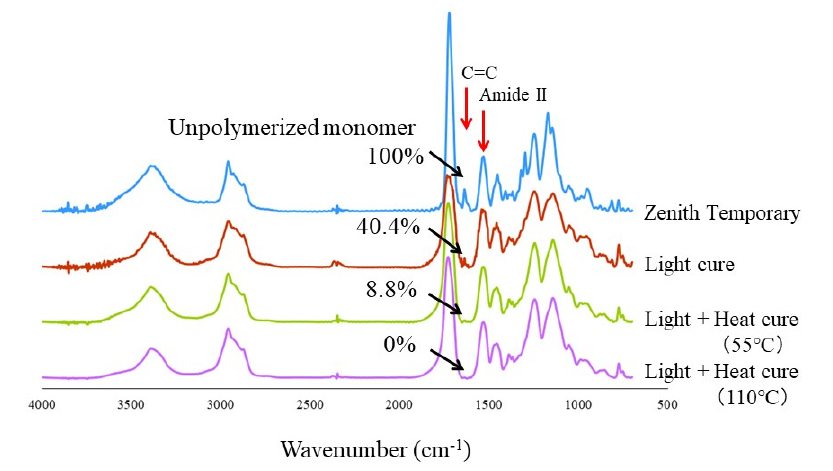
Figure 4. FT-IR spectra of the specimen surfaces.